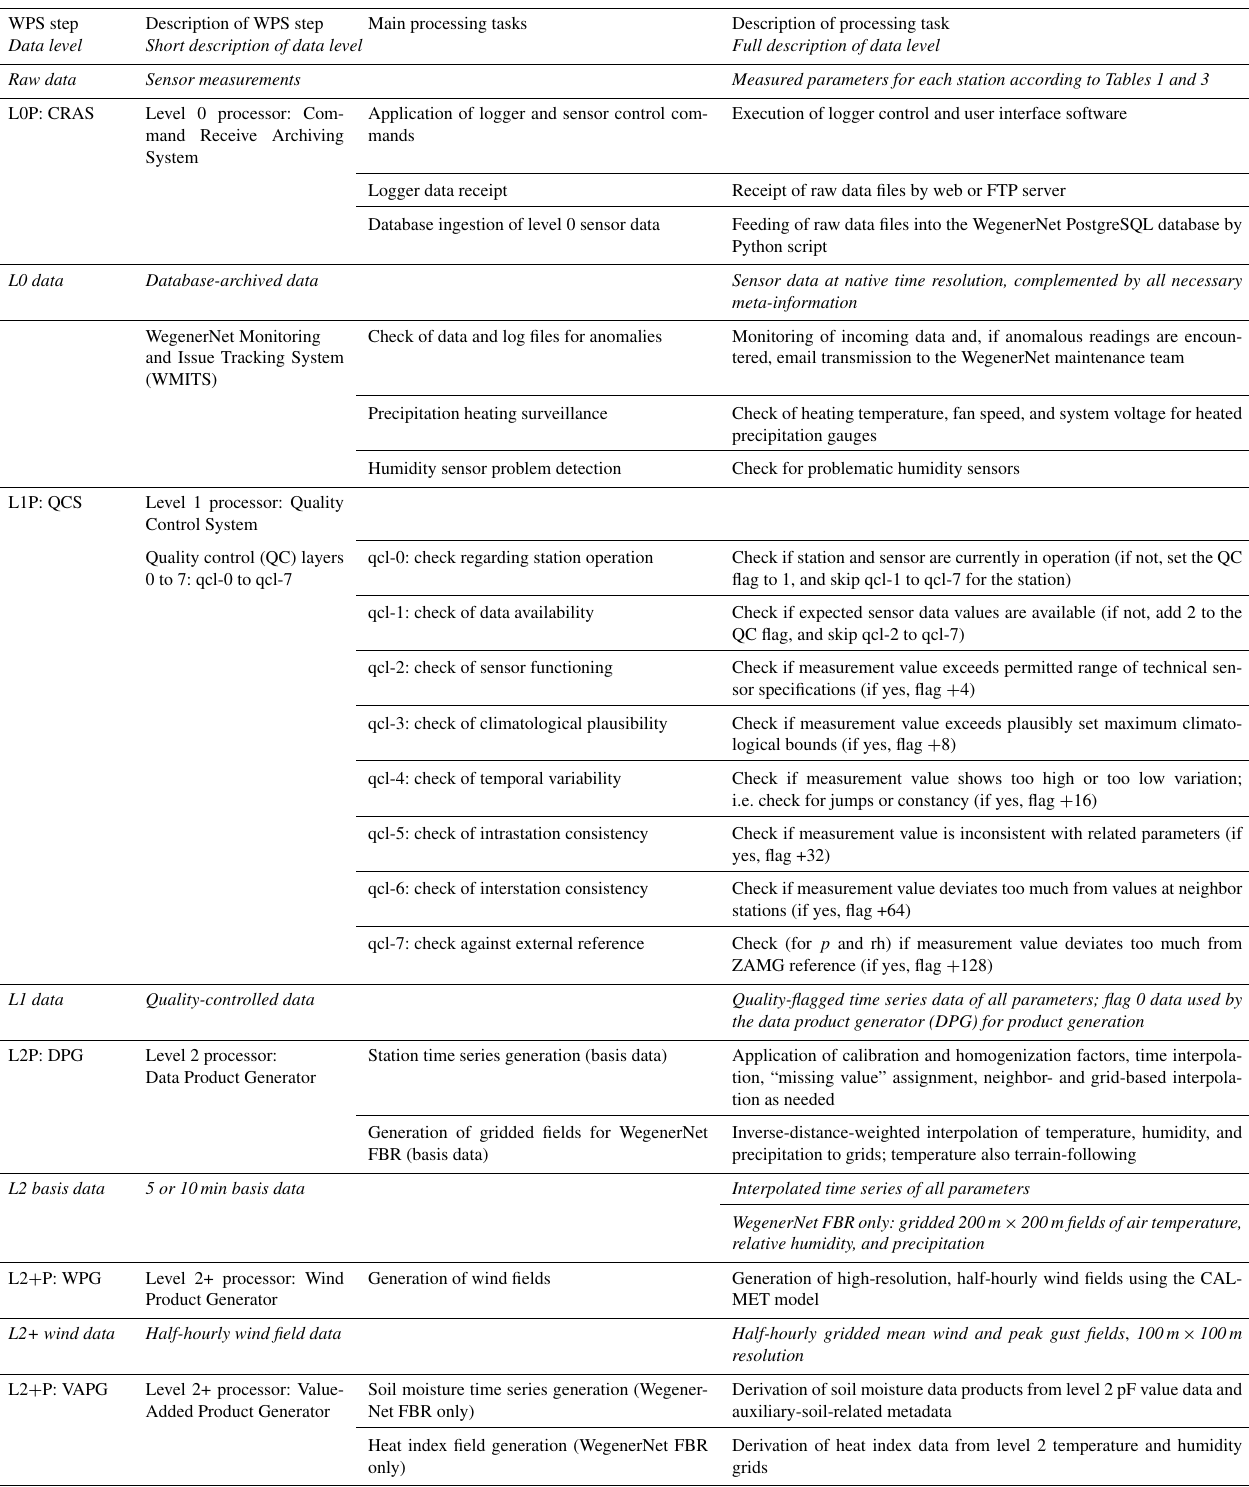
Table 4. Overview of the WegenerNet Processing System (WPS) tasks and its different levels of output data. (Task descriptions are written in non-italic text, whereas output data descriptions are